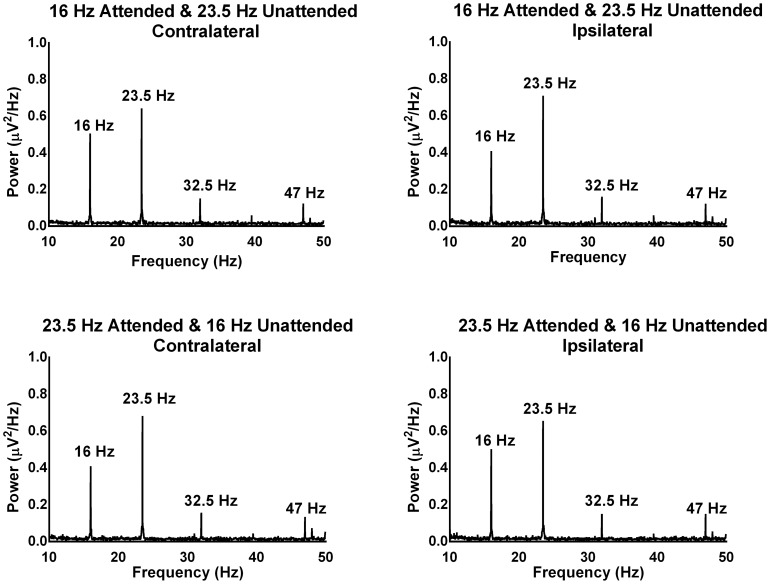
The grand mean FFTs for 16 and 23.5 Hz modulation frequencies during attended and unattended conditions across ipsilateral and contralateral activations combined from the two electrodes (T7 & T8).The power in the FFTs is an absolute value expressed in terms of squared microvolts per every 1 Hz of frequency (µV2/Hz). The first harmonics for both 16 and 23.5 Hz are also shown.